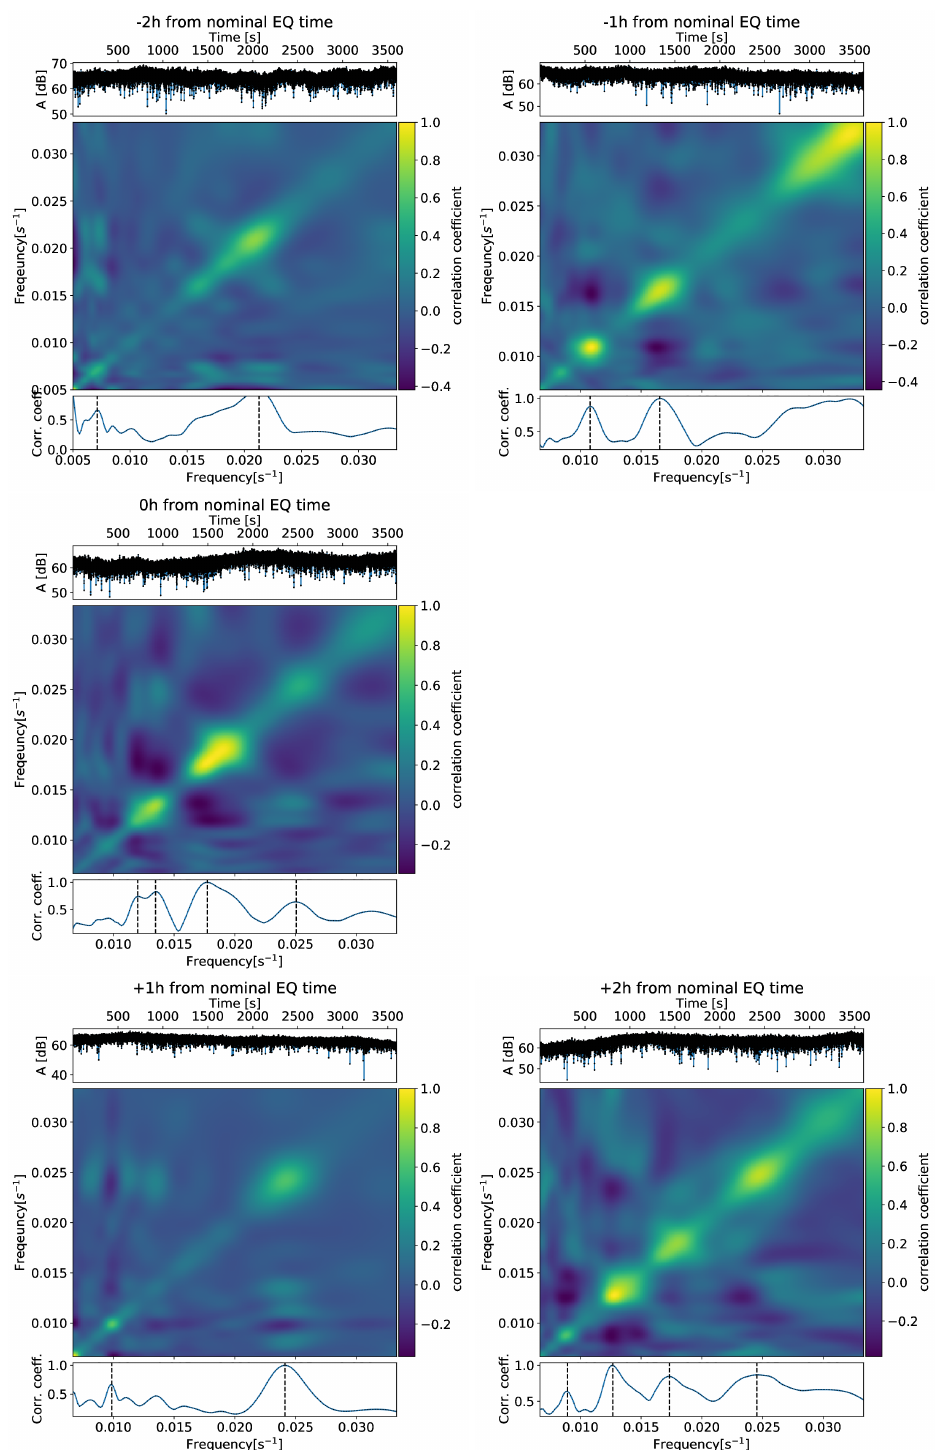
Figure 3. The same as Figure 2 but for date 1 year